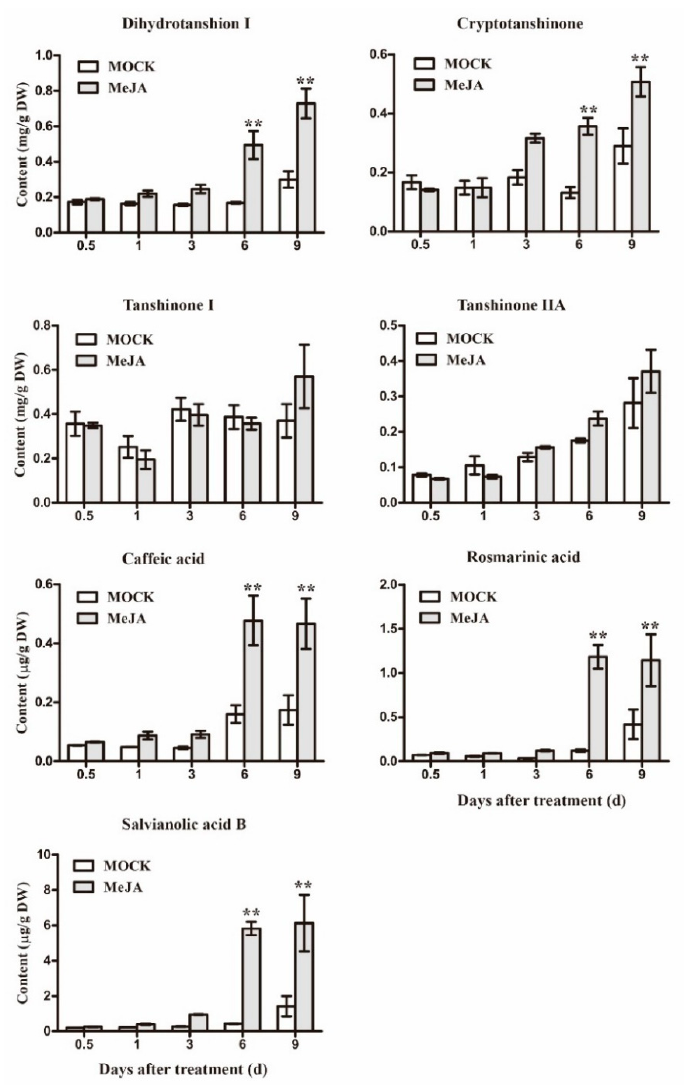
Figure 5. Effects of MeJA on accumulations of tanshinones and phenolic acids in S. miltiorrhiza hairy roots. The vertical bars show the SD values ( n = 3). The asterisks indicate statistically significant differences at p < 0.05 ( ** p < 0.01) between the content in the MeJA treated cultures and that in the corresponding controls.